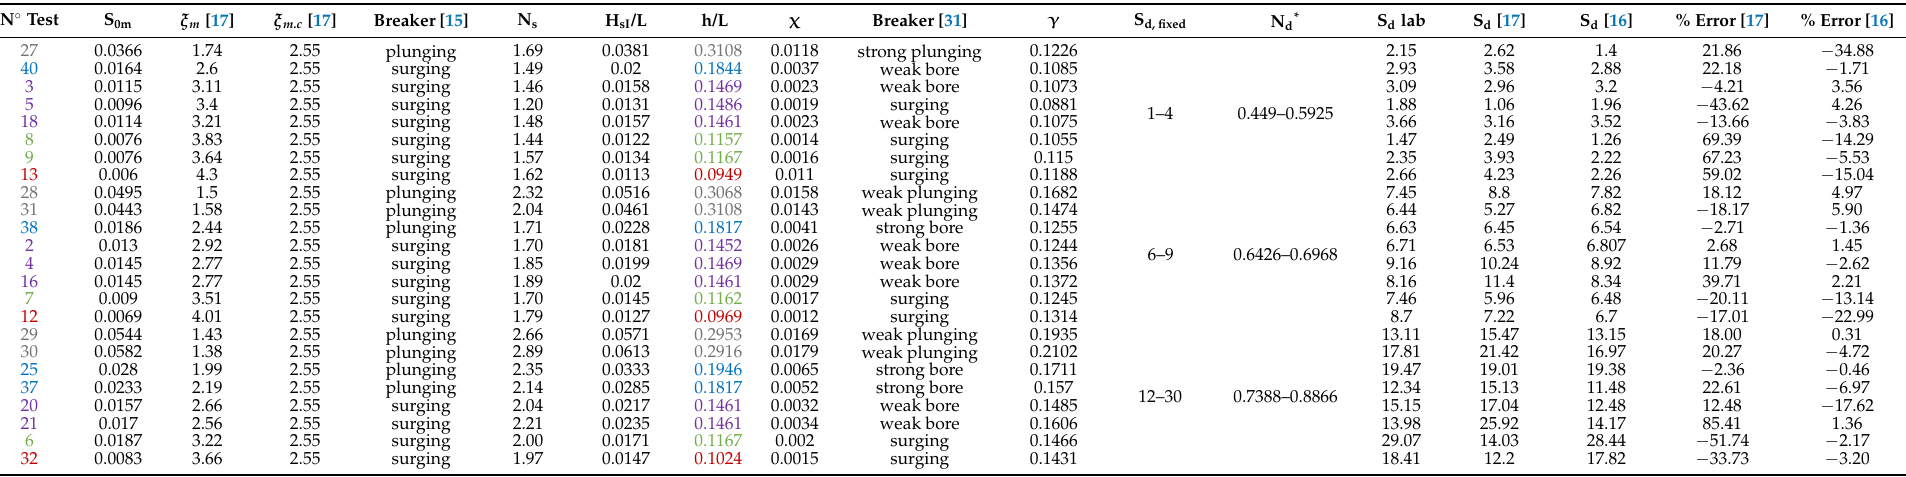
Table A1. Experimental data conditions for some of the Pierson Moskowitz data tested by Van der Meer [28]. The damage level and the error calculated by the formula of Van der Meer and the sigmoid function proposed by Losada [16] are included. The wave breaker types according to Van der Meer and following the works of Moragues and Losada [31] are also compared. By colors the values of relative water depth in deep water are included following Figure